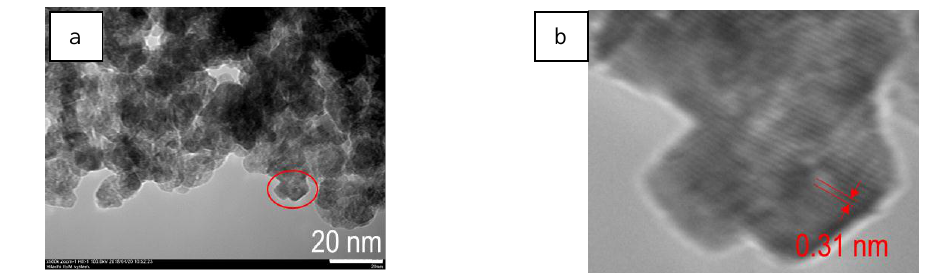
Fig. 1. TEM images of the (a) Y 0,45 Ce 0,5 Tb 0,05 F 3 nanoparticles (b) highlighted area.